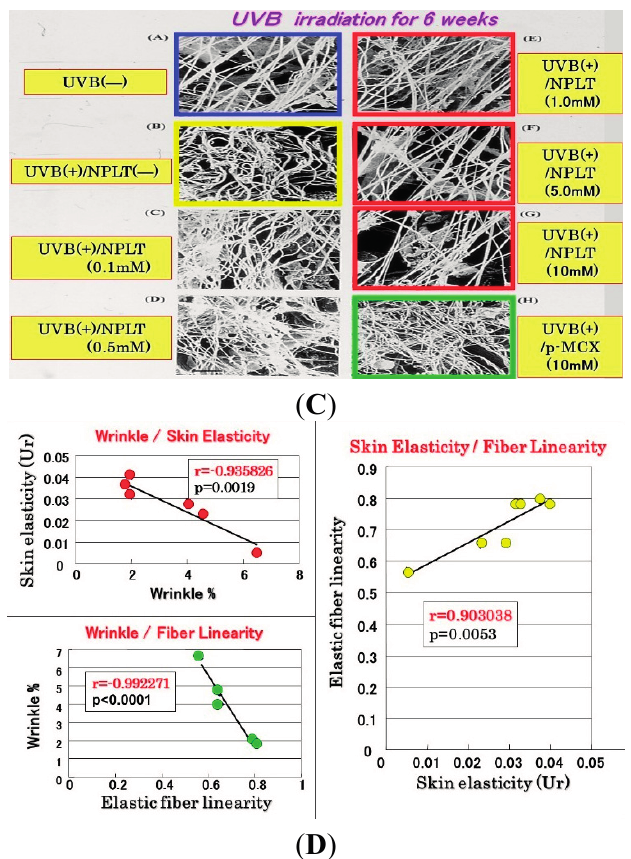
Figure 10. Effects of NPLT on UVB-induced wrinkling. ( A ) Experimental protocol. Rats were placed in cages individually and were irradiated by a bank of five Toshiba SE lamps (UVB) without any filtering, three times a week for a total of six weeks. The distance from the lamp to the animal’s hind limbs was 42 cm (irradiance was approximately 0.72 mW/cm 2 ), and a dose of 130 mJ per cm 2 (rat 1 suberythemal dose = 170 mJ/cm 2 ) was given three times weekly. The relative spectral contributions of Toshiba SE lamps used in this study were 63%, 36%, and 0.5% in the UVB (290–320 nm), UVA (320–400 nm), and UVC (<290 nm) regions, respectively; ( B ) Effect of topical application of NPLT on elasticity of UVB-irradiated rat hind limb skin. The skin elasticity, expressed as physical parameters Ue, Uv, Ur, and Uf, was measured with a Cutometer. These measurements were carried out at an age of nine weeks. ***, **, * p < 0.005, 0.01, 0.05 ( vs. irradiated/EtOH treatment); ### , ## p < 0.005, 0.01 ( vs. unirradiated/untreated); Ue, immediate distension measured at 0.1 s; Uv, delayed distention; Ur, immediate retraction; Uf, final distention. n = 10, values represent mean ±